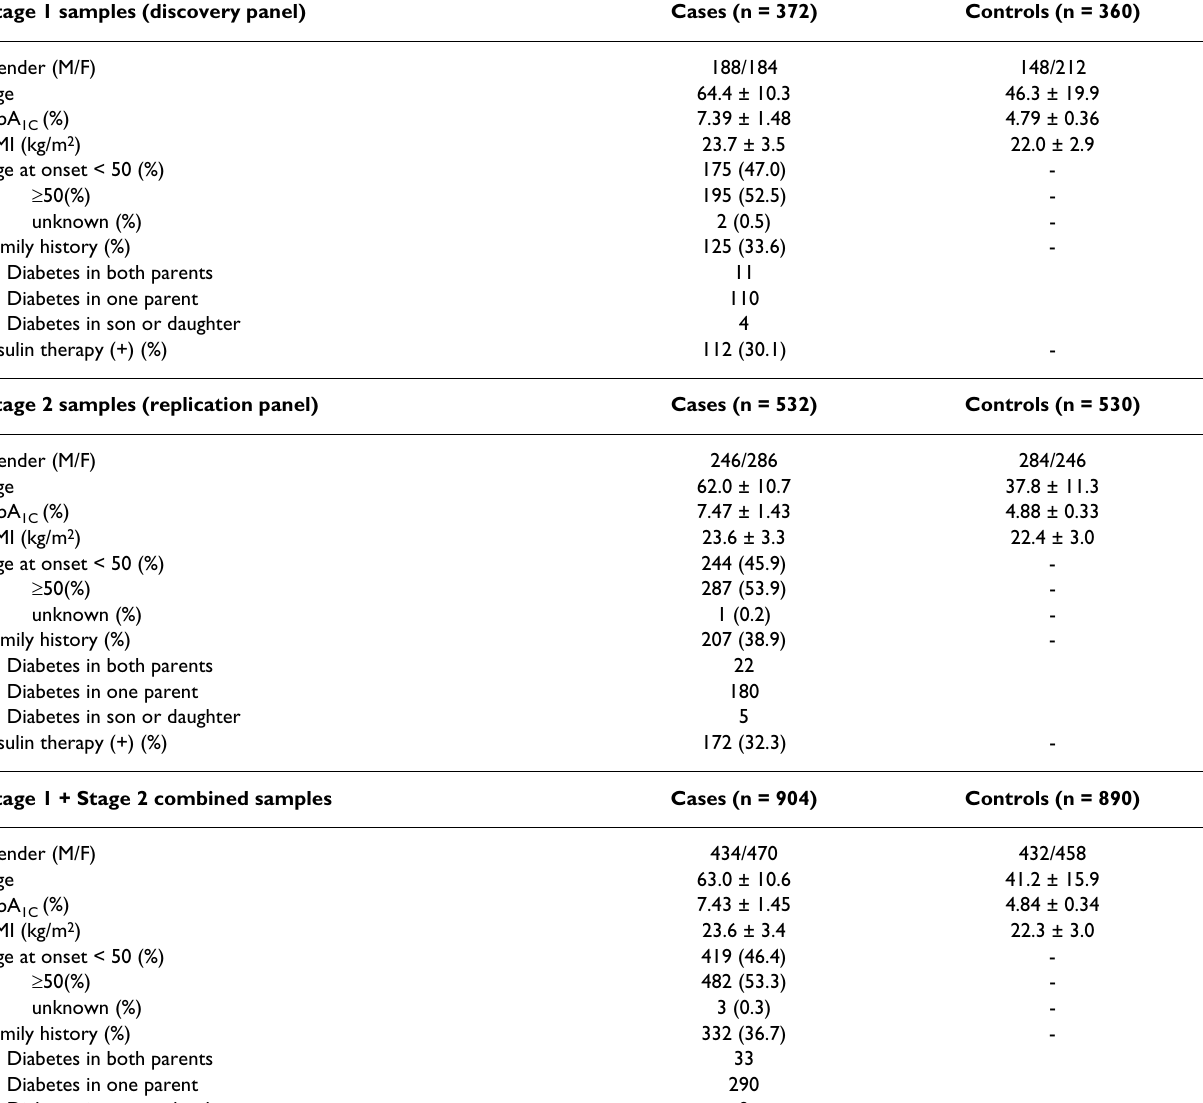
Table 2: Characteristics of the 1,794 Japanese subjects used in the association tests Stage 1 samples (discovery